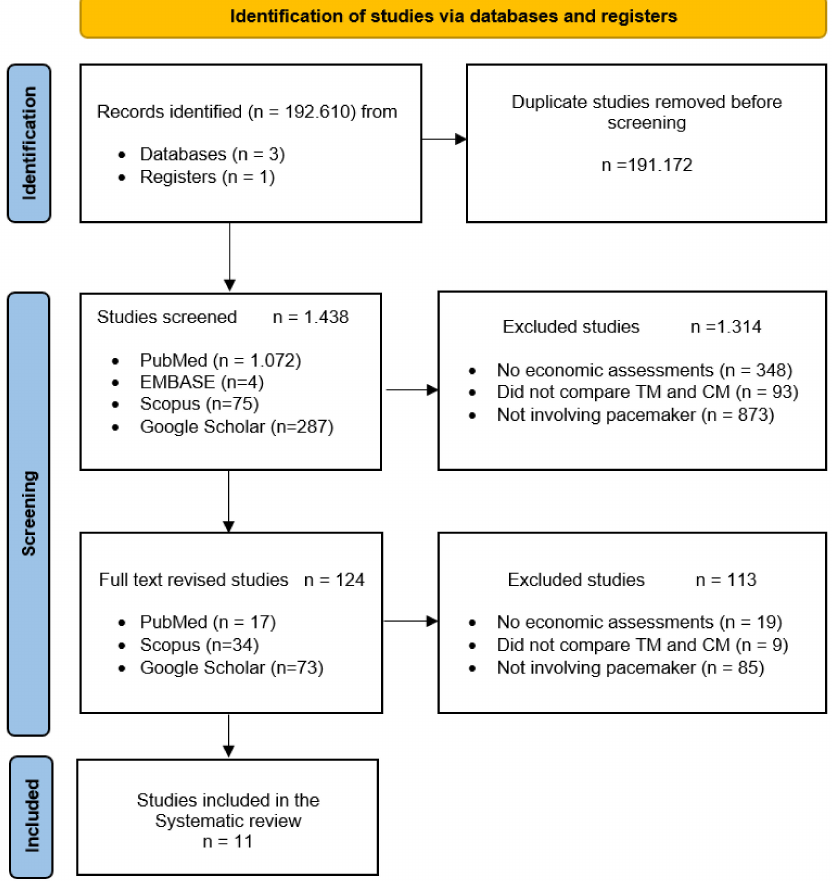
Figure 2. PRISMA flow diagram [52] of the selection process of studies for the systematic review of economic evaluations of remote monitoring systems and follow-up of patients with pacemakers. CM—Conventional monitoring;